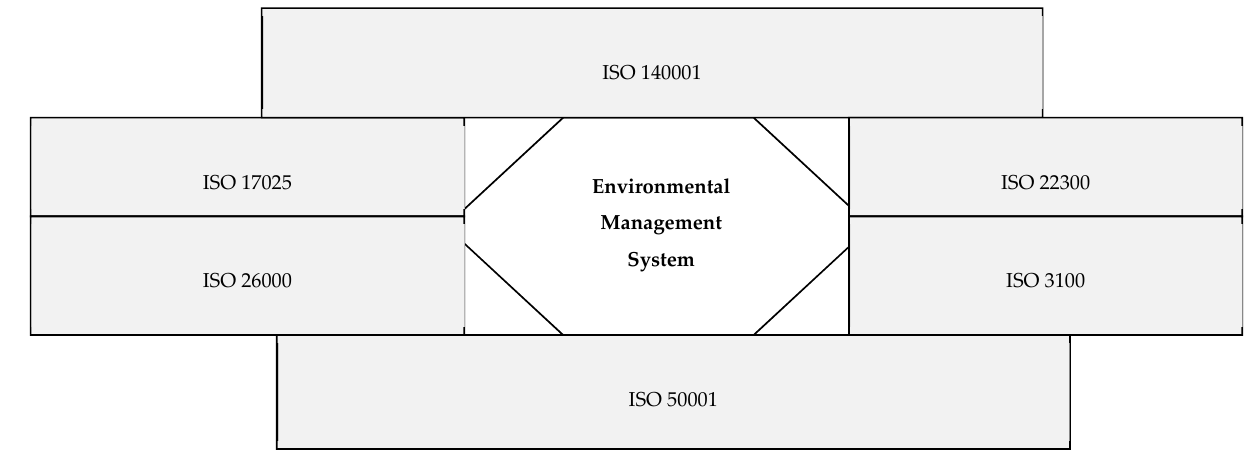
Figure 1. Author’s recommendations for energy companies listed on the Polish stock exchange in the area of reporting environmental management information. Source: the authors.